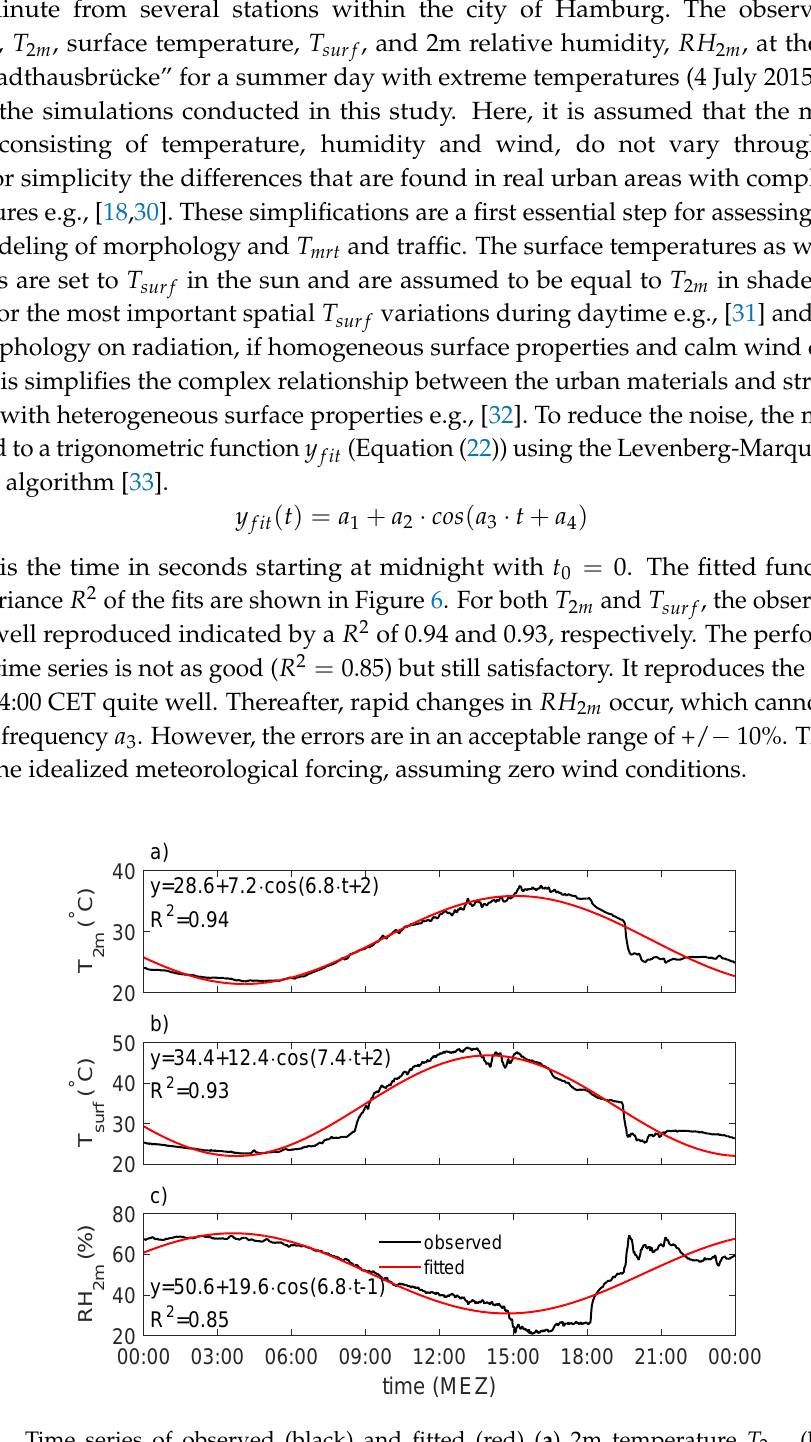
Figure 6. Time series of observed (black) and fitted (red) ( a ) 2m temperature T 2 m , ( b ) surface temperature T surf , and ( c ) 2m relative humidity RH 2 m at the station “Innenhof Stadthausbrücke” for 4 July 2015. The equations for the non-linear fit are given as well as the corresponding explained variance R 2